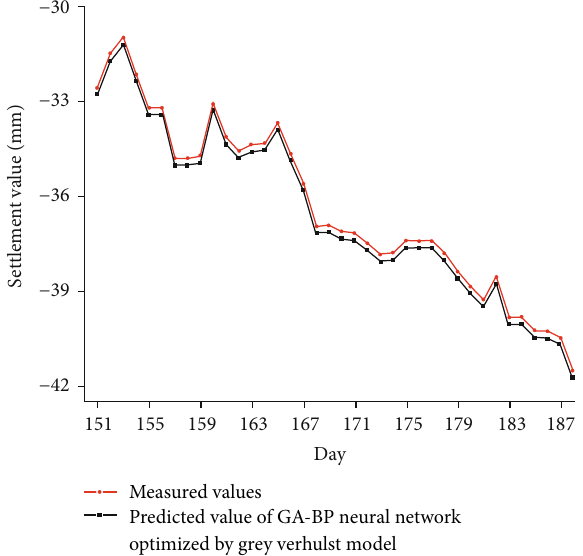
Figure 7: Comparison between measured values and predicted values of GA-BP neural network optimized by grey Verhulst